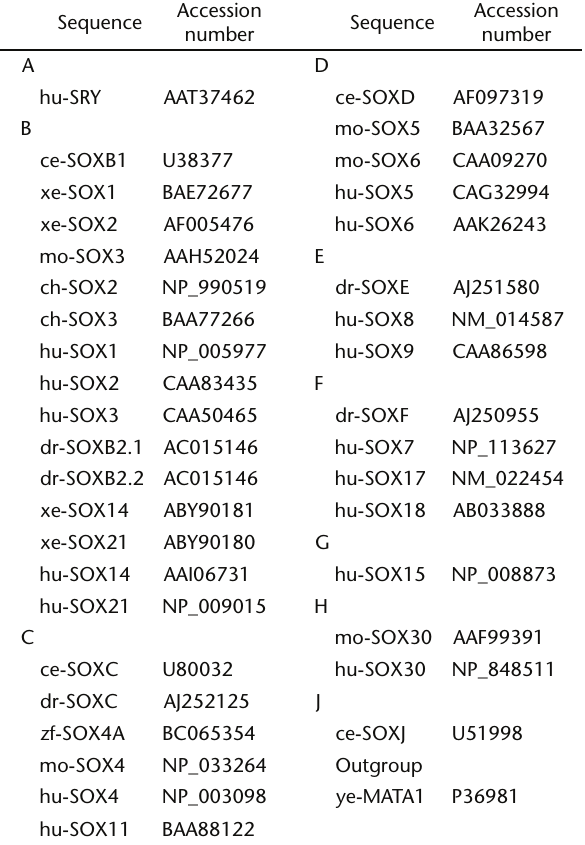
Table I. Sox gene sequences used in this